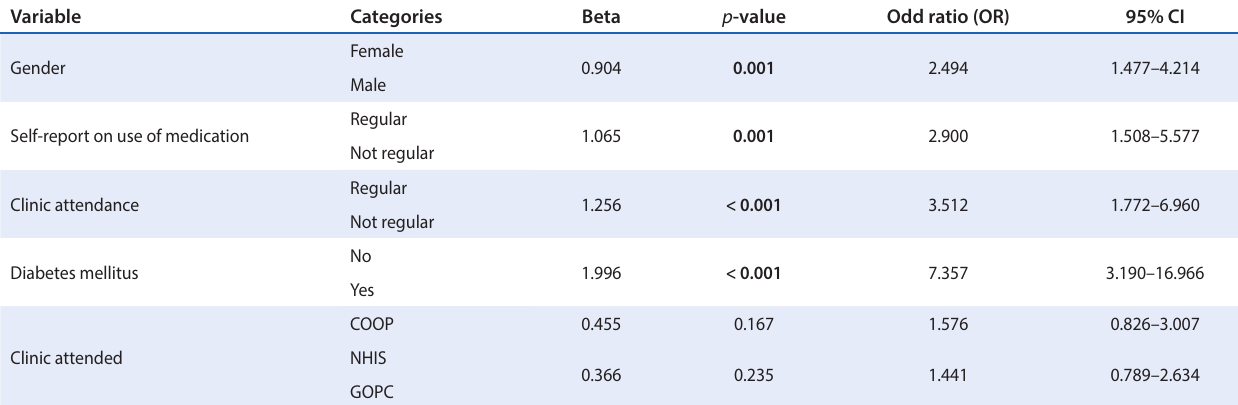
The independent predictors of controlled BP after logistic regression analysis were female gender, regular use of medication, regular clinic attendance and absence of diabetes